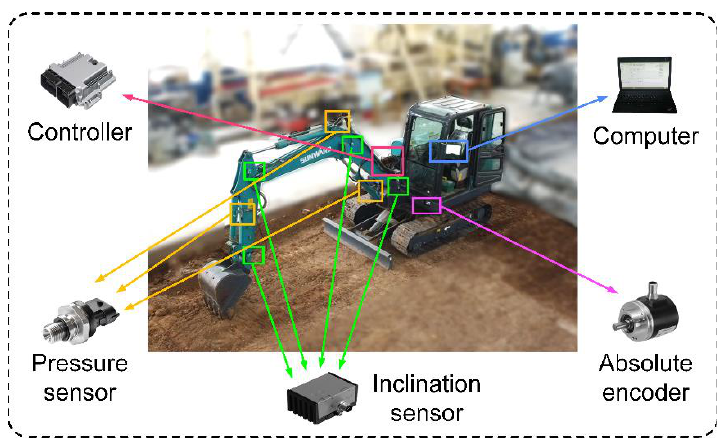
Figure 1. Overview of the hardware setting.